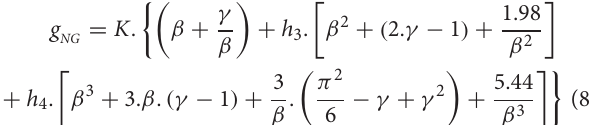
TABLE 2 | Small-scale parameters of models